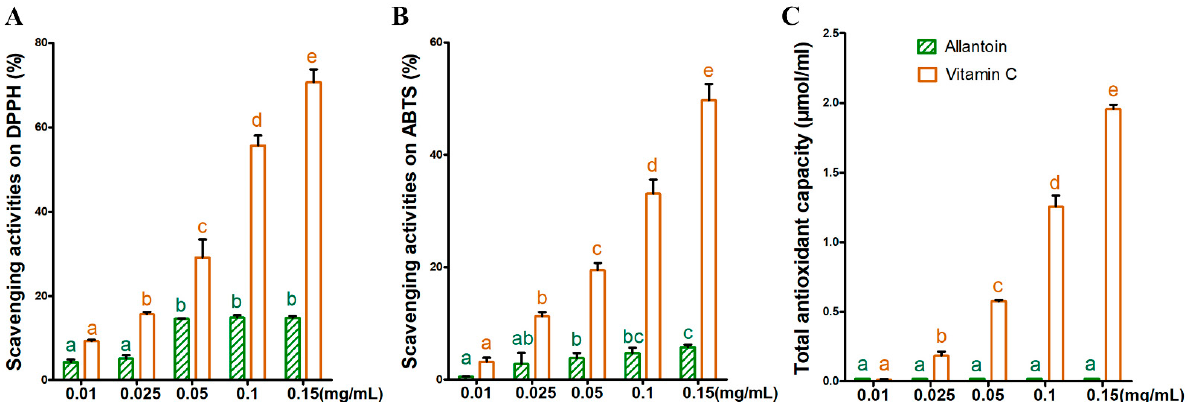
Figure 2. Determination of the antioxidant activity of allantoin in vitro. Evaluation of the ability of allantoin and ascorbic acid to scavenge DPPH free radicals ( A ) and ABTS free radicals ( B ) as well as their total antioxidant capacity (T-AOC) ( C ). Letters a,b,c,d and e represent the results of significant difference analysis. The same letter marks indicate no significant difference between two groups of data, while different letters indicate a significant difference between two groups of data ( p < 0.05).